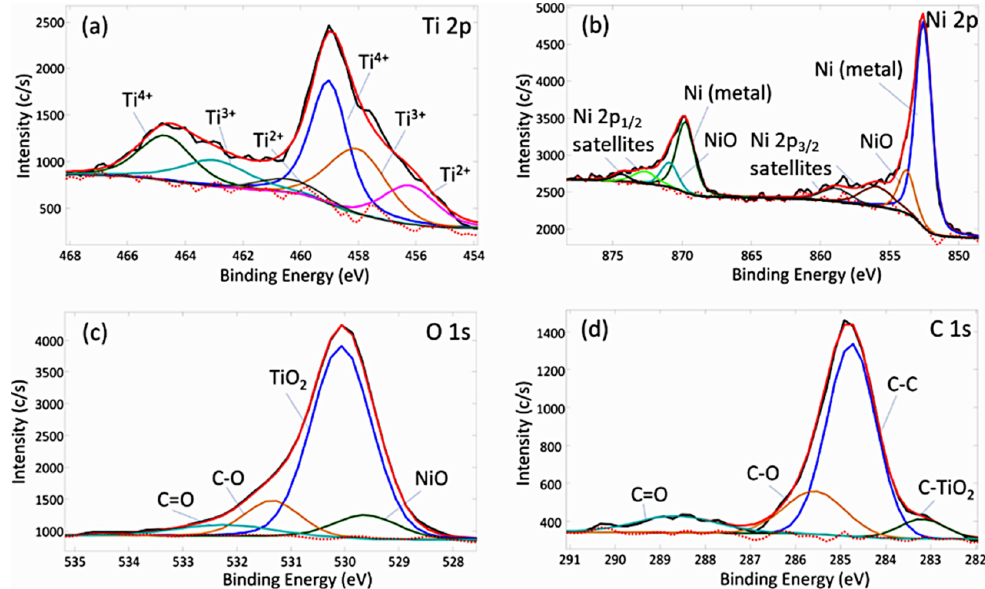
Figure 8. XPS chemical bond analysis: ( a ) Ti 2p, ( b ) Ni 2p, ( c ) O 1 s and ( d ) C 1 s spectra.